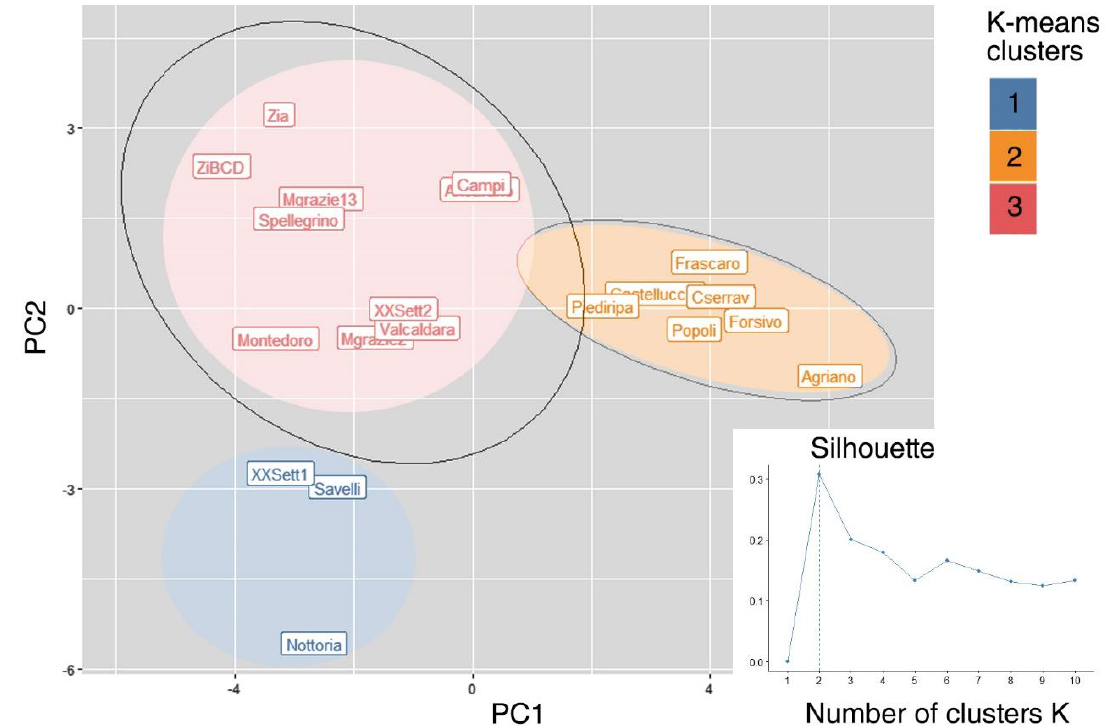
Figure 5 K-means analysis (K=3). In the corner the plot used to evaluate the choice of